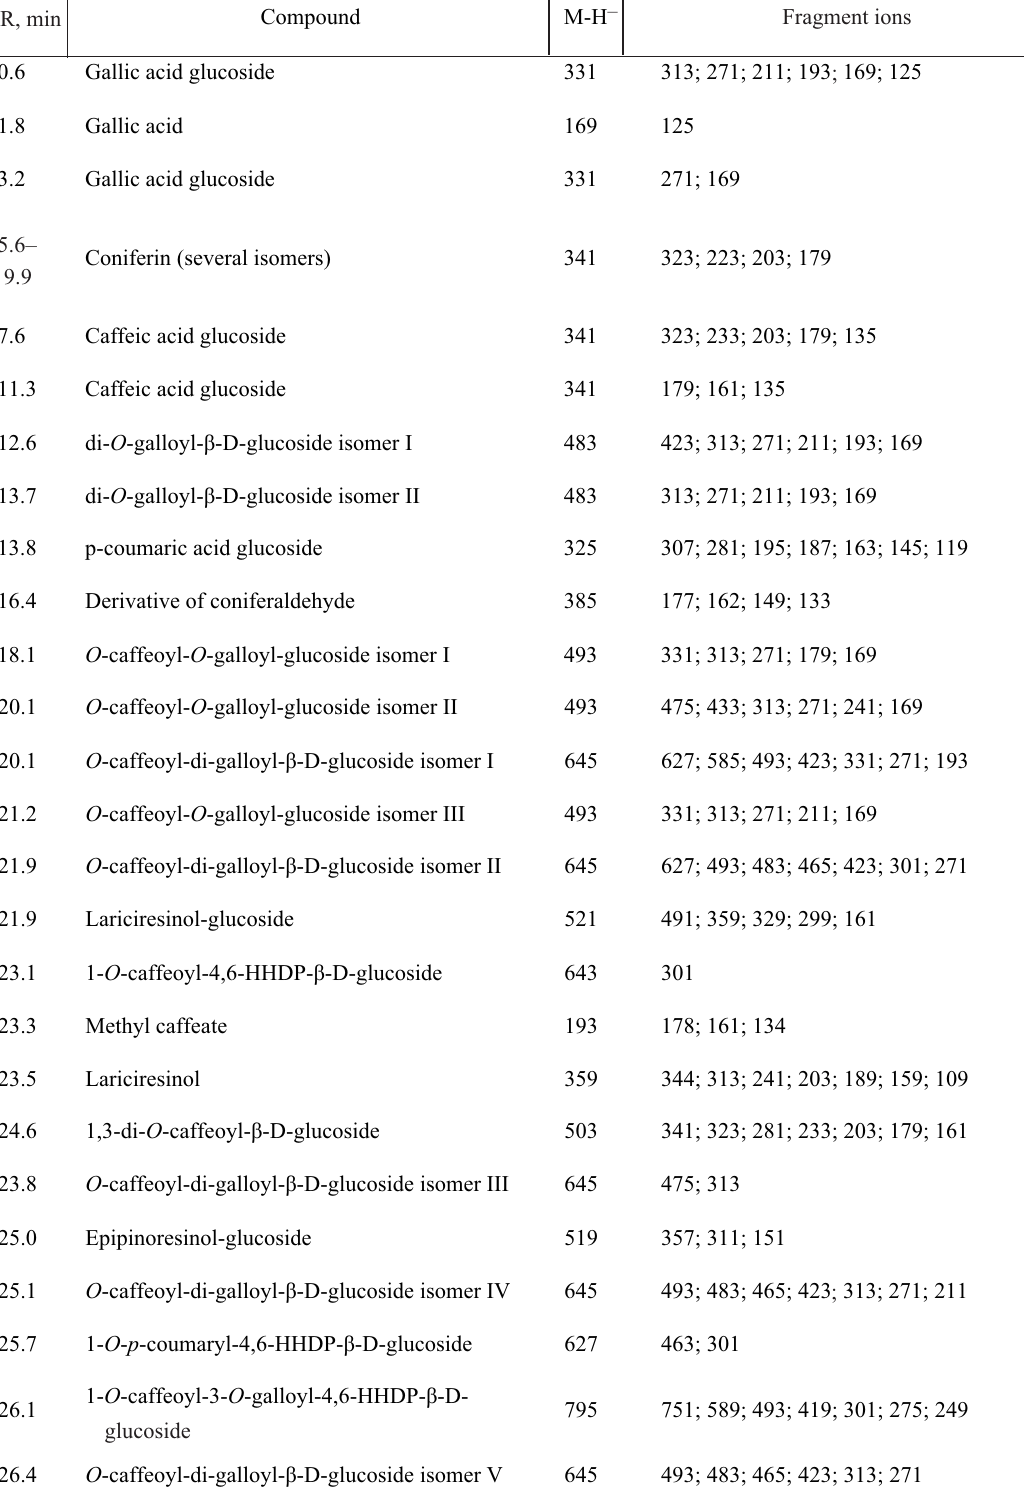
Table 5. Characterization of HPLC chromatograms of the methanolic extracts of BFG and